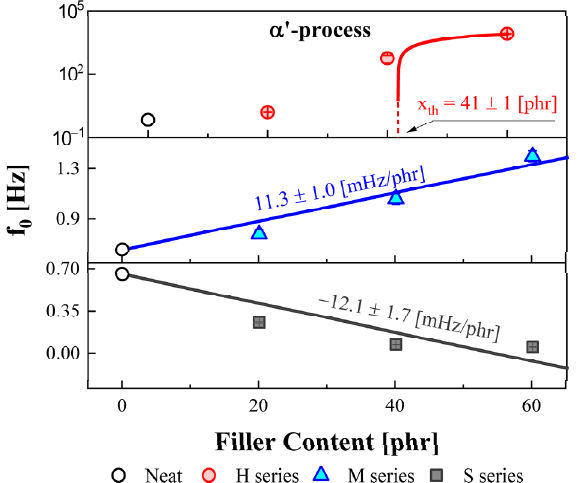
Figure 4. Variation of the central relaxation frequency for the α′ process with different filler types and contents. The red circle indicates the H series, and the blue triangle and gray square symbols indicate the M and S series, respectively. The red solid line indicates that fitting result of Equation (8) and blue and gray solid lines represent the linear fitting results of f0 versus the filler concentra- tion.